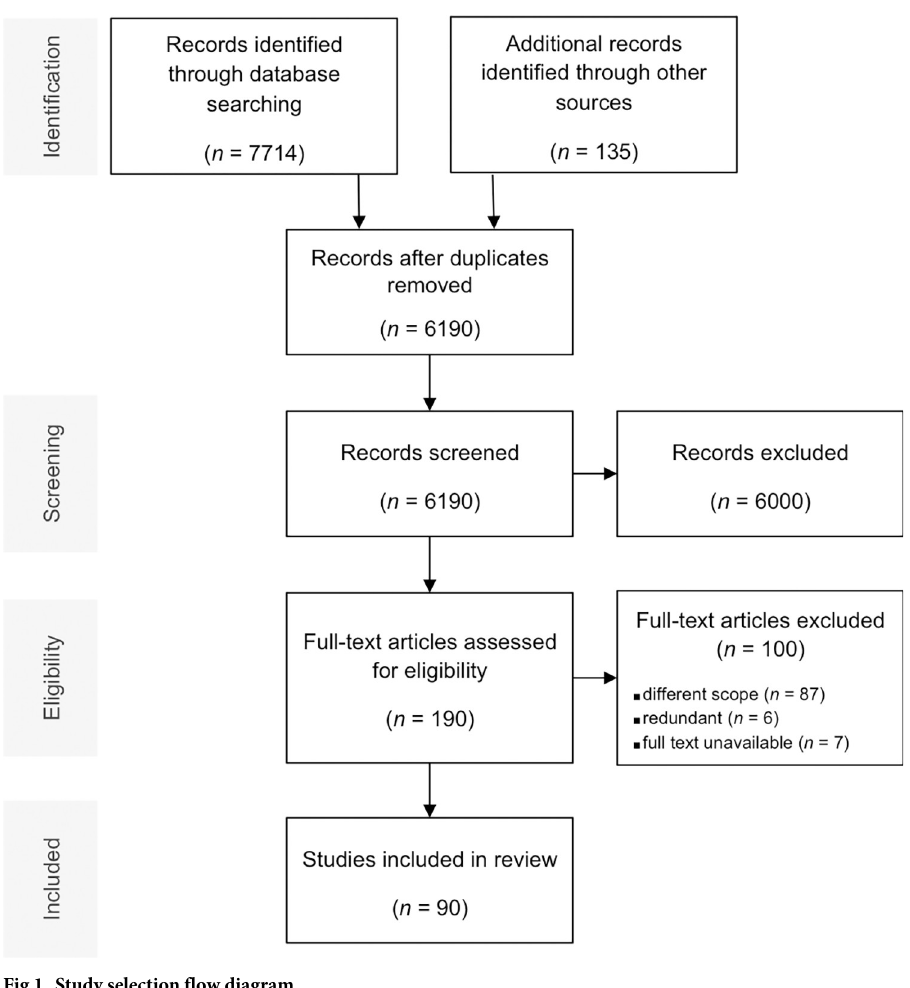
Fig 1. Study selection flow